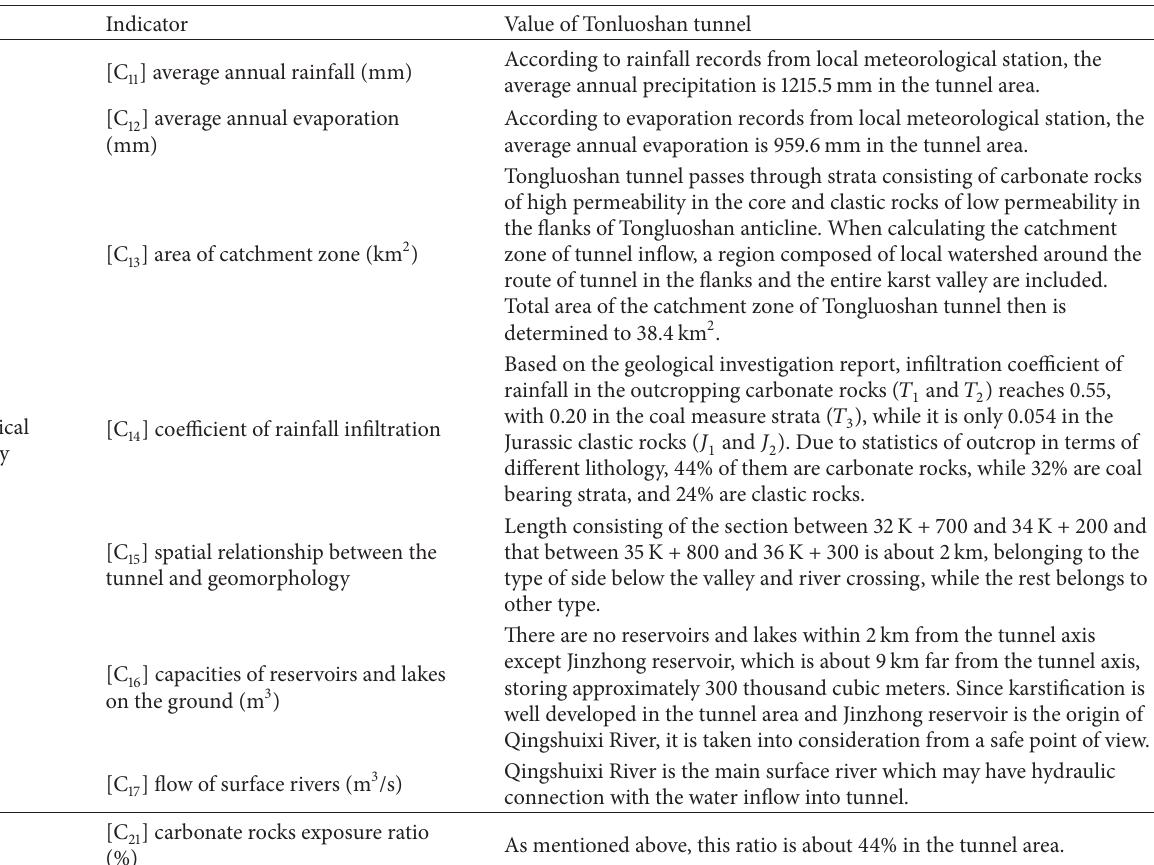
Table 4: Quantification of each factor included in the indicator